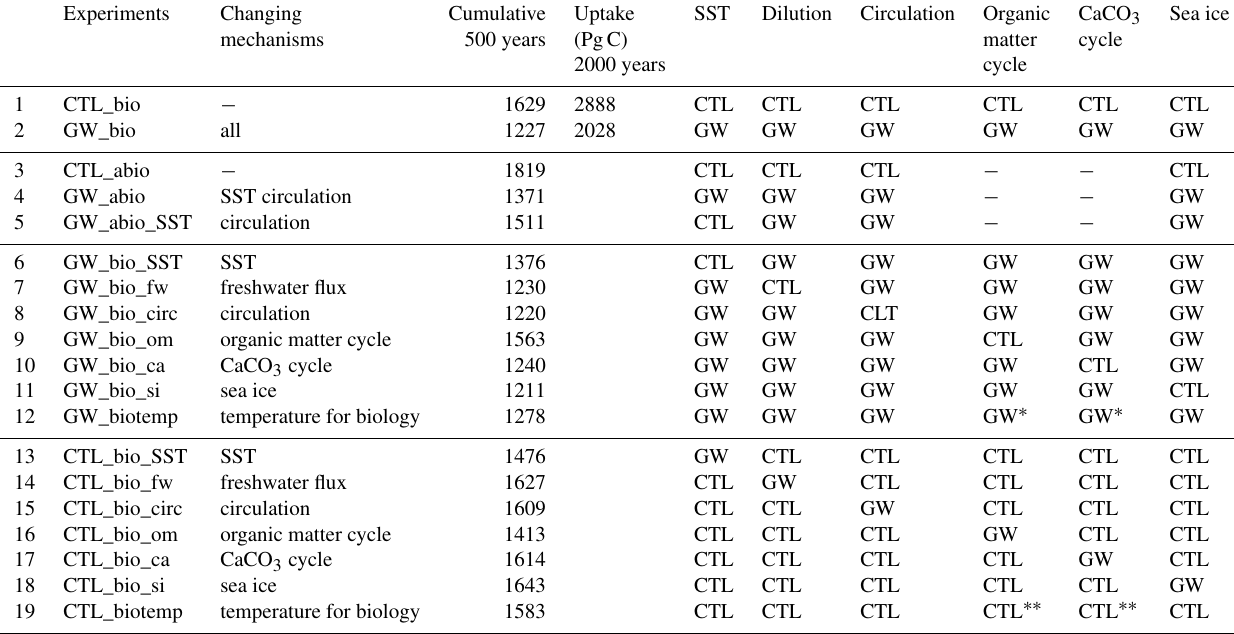
Table 1. Description of the model experiments and results for oceanic CO 2 uptake.